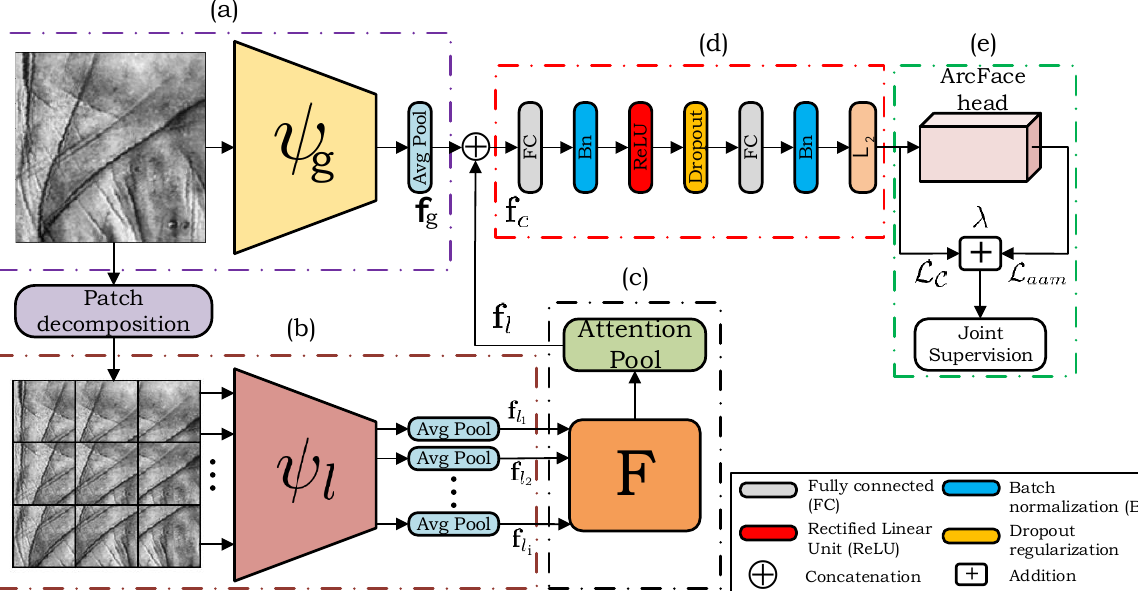
Figure 3. Overview of the proposed method for contactless palmprint recognition. Our model is designed as a Two-path architecture. The first path of the model, marked ( a ), extracts holistic image information through a backbone CNN feature extractor. The second path, marked ( b ), represents the local processing path where the sampled patches from a fixed grid are processed through a parallel Siamese-based CNN feature extractor with shared model parameters. The next part of the model, marked ( c ), extracts the most relevant local information from the local image patches with a new channel-wise attention pooling mechanism. The global and the aggregated local features are then combined in ( d ). The final part of the model, marked ( e ), is only used during training and represents the joint supervision with the ArcFace and the center